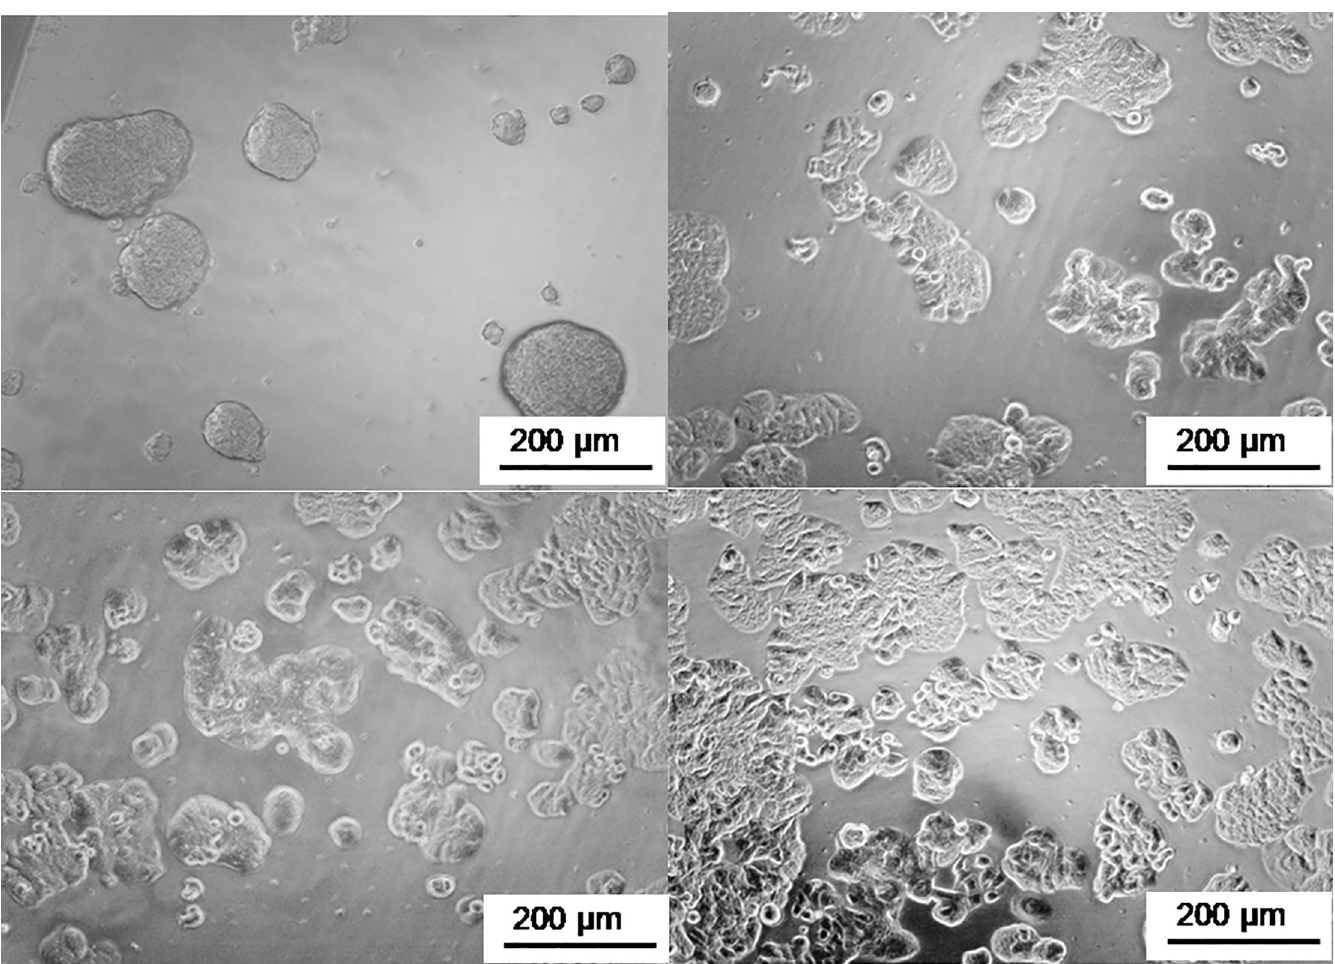
Fig 1. Microscopic images of HT29 cells on surfaces (1 h; 37˚C) treated with PEG6000 from A) C.E.; B) Acros; C) Merck; and D) S.A.. The images were recorded 48 h after cell plating.